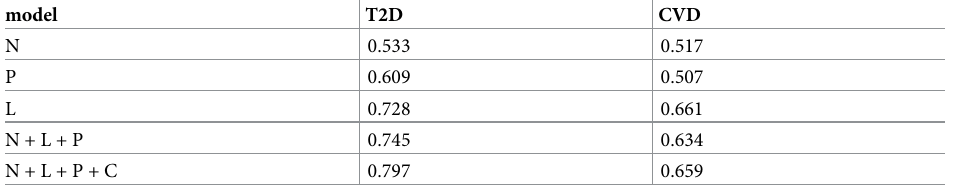
Table 1. AUC classification metric for the models underlying the different risk scores for T2D and CVD. We used class prediction probabilities averaged over the 10 independent cross-validation iterations during the AUC calculation.